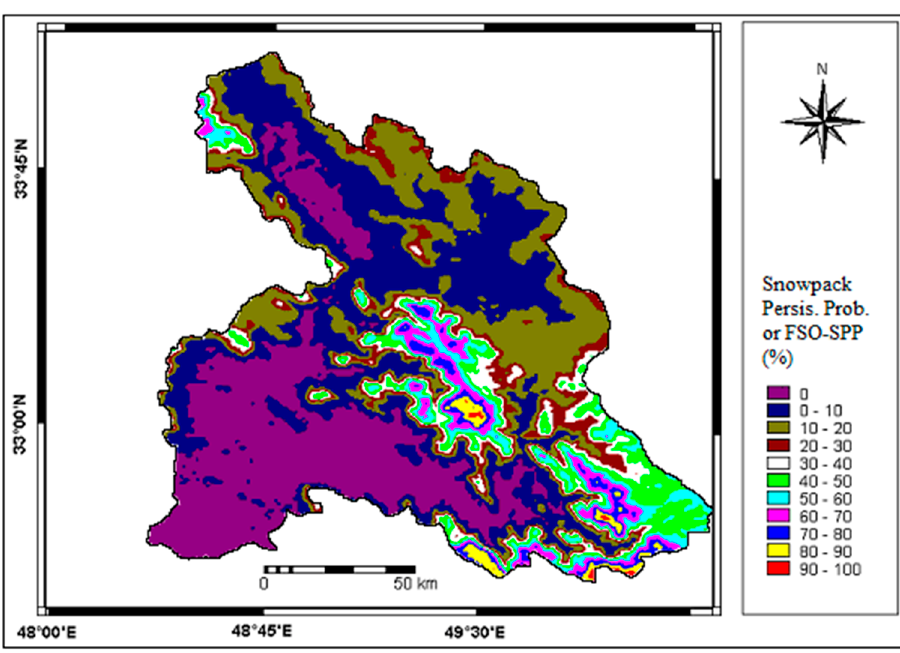
Figure 7. FSO ‐ SPP Map in Dez Basin (for the period of 1984–2003). Figure 7. FSO-SPP Map in Dez Basin (for the period of